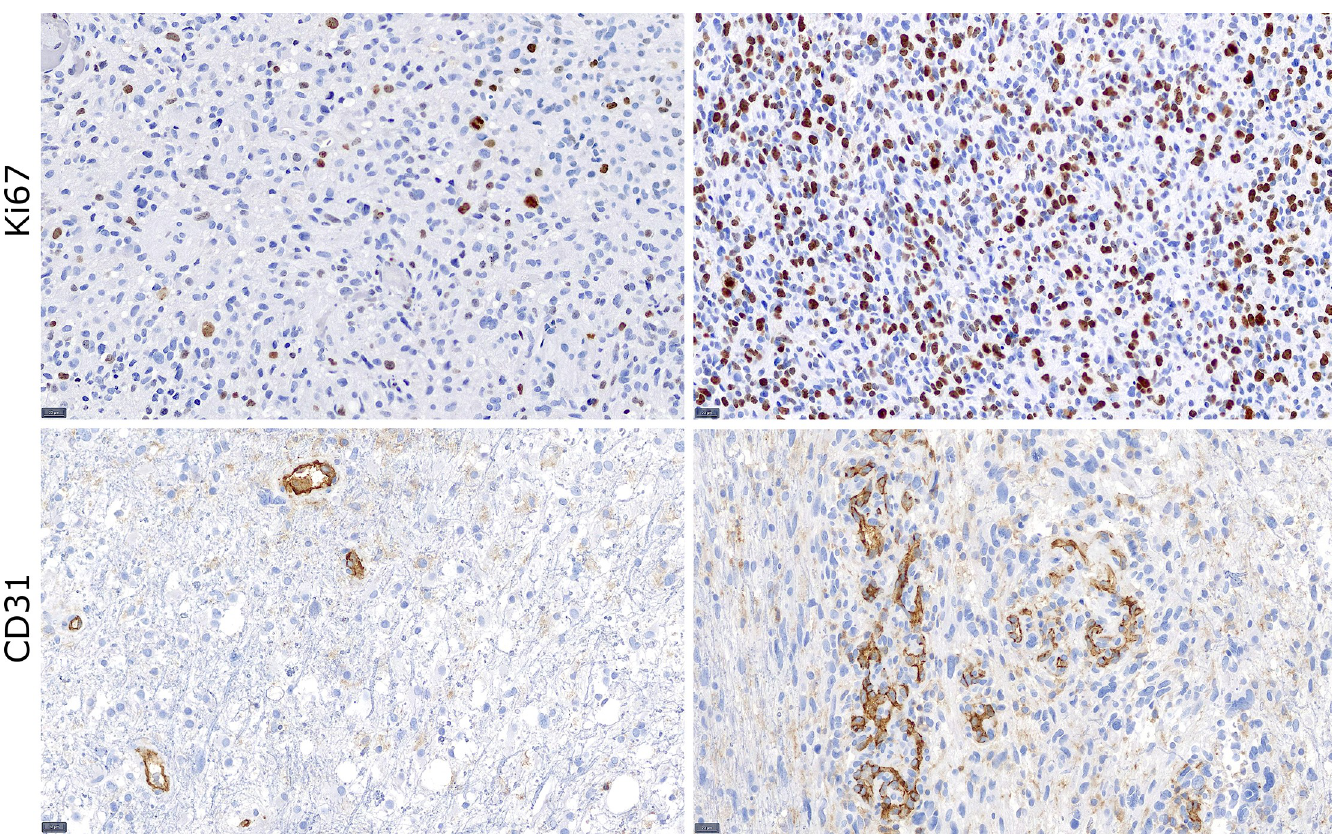
Fig 3. Exemplary histologic specimens of targeted tumor biopsies in a 20-fold magnification (black bars equal 20 μ m). The upper row shows Ki67 immunohistochemistry to determine the proliferative activity with a low percentage of 8% proliferating cells (left) and high percentage of 40% proliferating cells (right). The lower row shows CD31 immunohistochemistry to determine the amount of endothelial cells with a low vessel density (score 1, left) and a high vessel density (score 3,